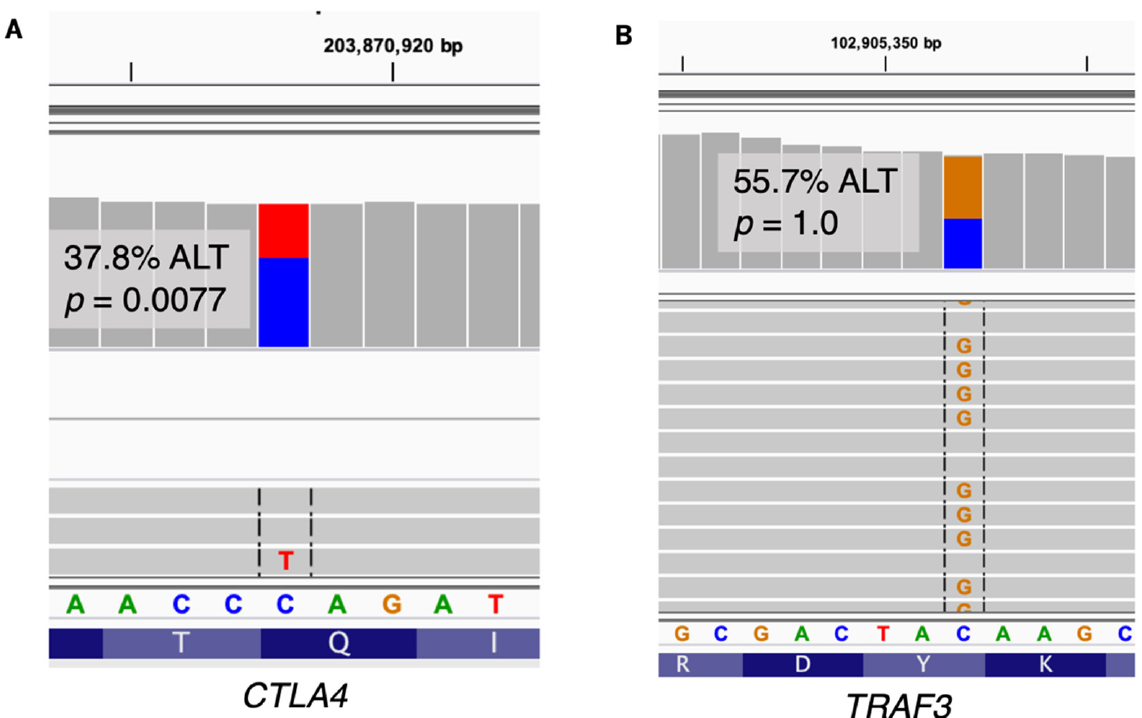
Figure 2. Variant allele-specific expression. ( A ) The nonsense variant in CTLA4 for patient P49 shows unbalanced expression (181 REF, 110 ALT; p = 0.0077), suggesting nonsense-mediated decay. ( B ) The nonsense variant in TRAF3 for patient CHB535 does not exhibit allele-specific expression (286 REF, 360 ALT; p = 1.0), suggesting it escapes nonsense-mediated decay. Reference allele (REF) and alternate allele (ALT) read counts refer to allele counts in the final VCF file.